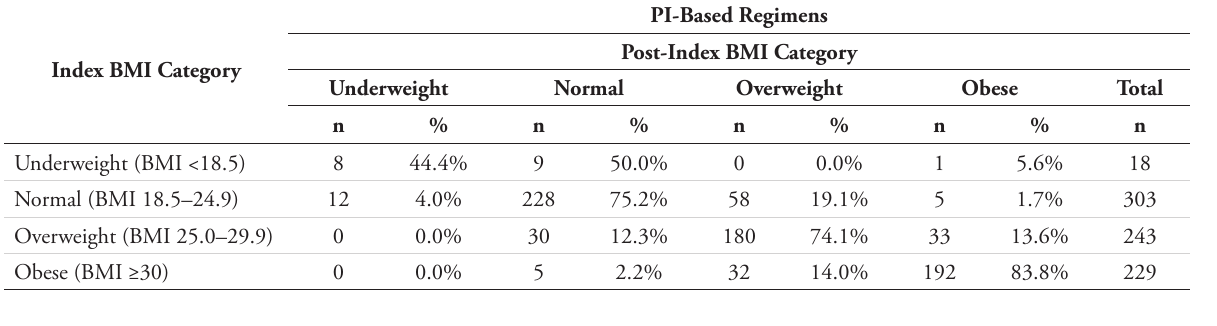
Table 2. Index BMI Category and Proportion of Patients with BMI Category Shifts During